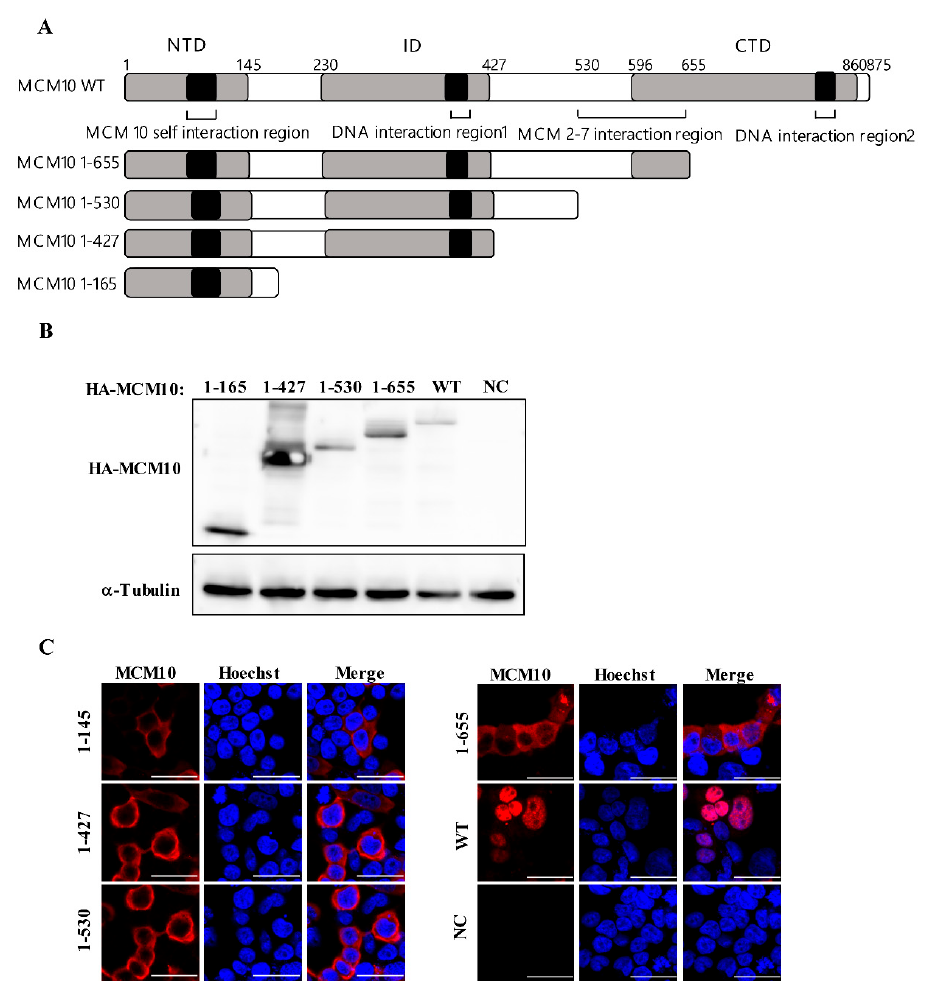
Figure 5. Expression and localization of MCM10 mutants. ( A ) Schematic diagram shows the domain structures of wildtype and MCM10 truncation mutants. Positions of the predicted N-terminal domain (NTD, 1-165), internal domain (ID, 230-427), C-terminal domain (CTD, 596-860), recently identified MCM2-7 interaction region (530-655). MCM10 self-interaction region involved in NTD and 2 DNA interaction regions located in ID and CTD are indicated. ( B ) Expression of MCM 10 mutants. HEK293T cells were transiently transfected with pcDNA3.1/HA-MCM10 WT, 1-165, 1-427, 1-530, or 1-655, respectively. Transfected cells were harvested at 48 h of post-transfection and lysates with the equal protein amounts were subjected to western blotting. The positions of HA-MCM10 and α -Tubulin are indicated. ( C ) Subcellular distribution of MCM 10 mutants. HEK293 cells were transiently transfected with either pcDNA3.1/MCM10 HA-WT, HA-1-165, HA-1-427, HA-1-530, or HA-1-655 and the subcellular distribution of MCM 10 mutants was determined via immunofluorescence staining with anti-HA mouse mAb at 48 h post-transfection. The nucleus was stained with Hoechst 33342 and observed using an FV-1000 fluorescence microscope. Bar = 20 μ m.